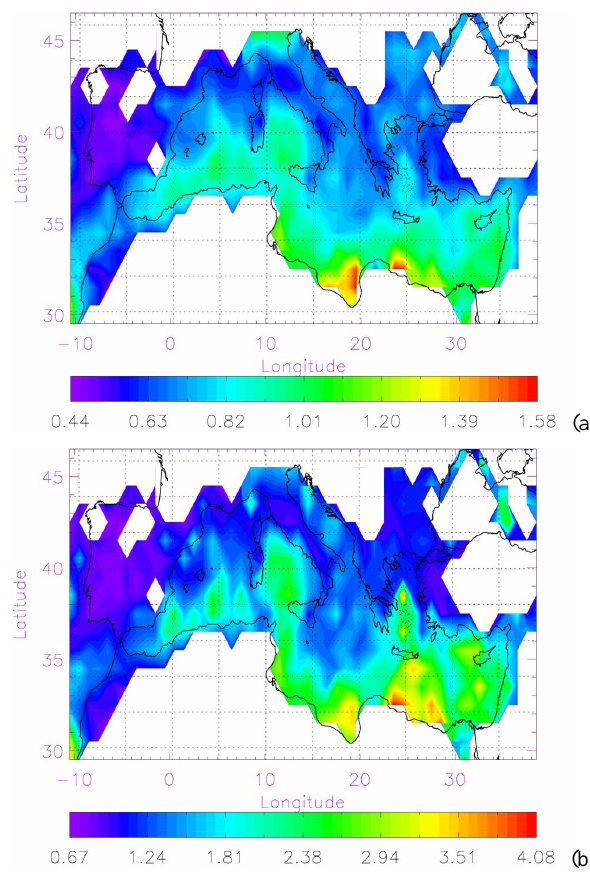
Fig. 4. Geographical distribution of the intensity of aerosol episodes (by means of AOD) over the broader Mediterranean basin for the period 2000–2007: (a) for strong aerosol episodes and (b) for extreme aerosol episodes.